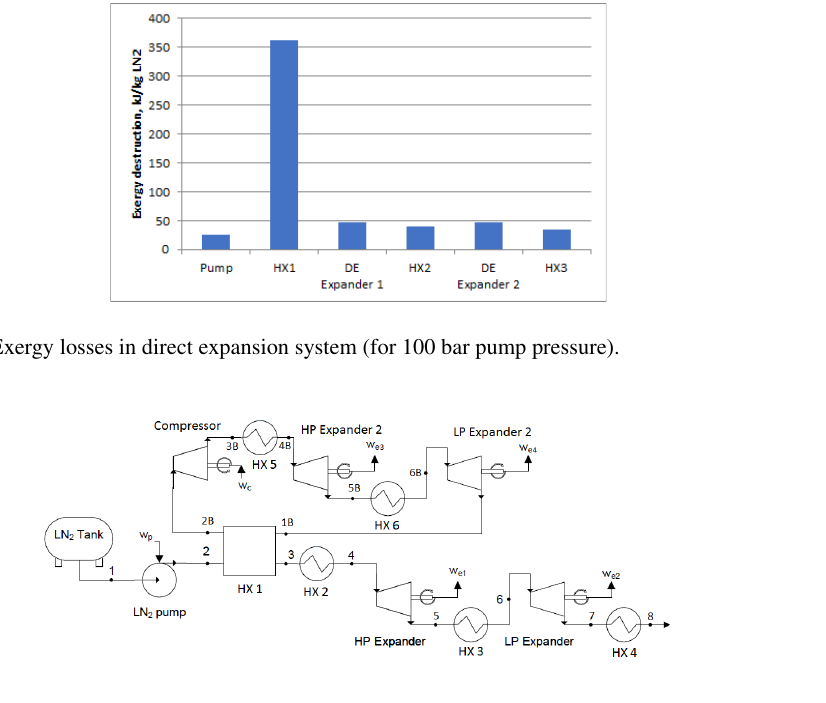
Figure 5. Scheme of combined direct expansion / Brayton cycle LN 2 exergy recovery system.